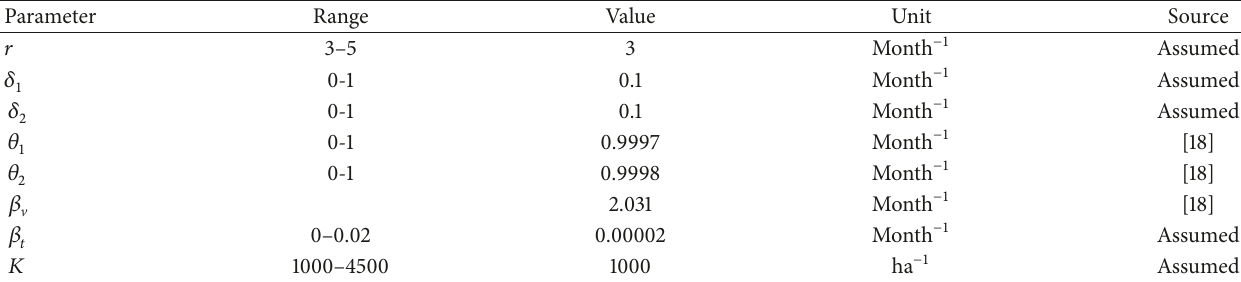
Table 1: Values used for model simulations.